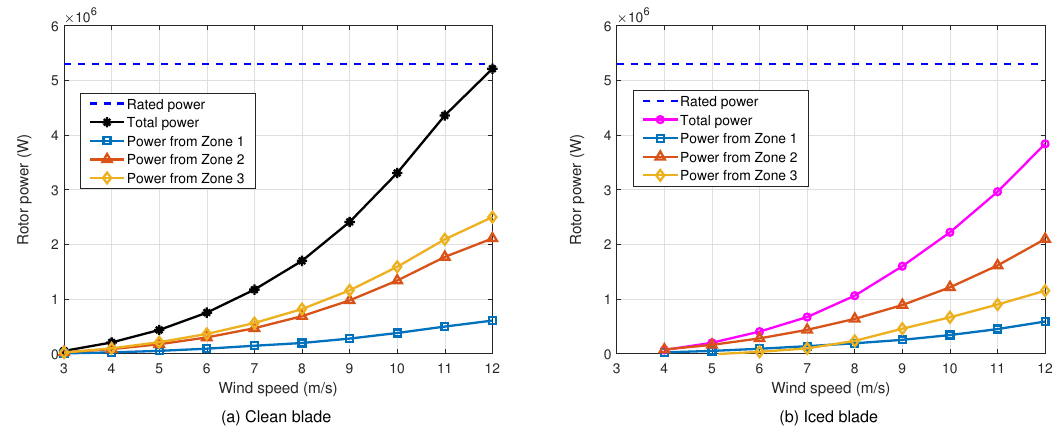
Figure 13. Contribution from different parts of the blade to turbine’s total mechanical power: Clean vs. iced blades (refer Figure 4 for identifying spatial locations of zones 1–3 along the blade).